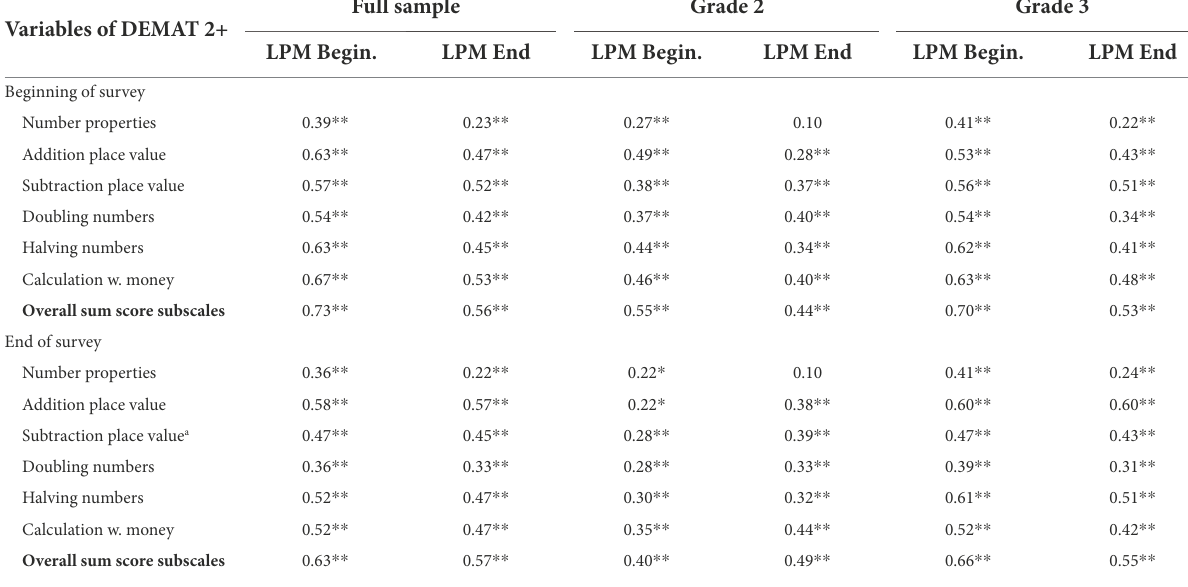
TABLE 7 Correlations of LPM scores at the beginning and end of the survey with subscales of the DEMAT 2+. Full Variables of DEMAT 2+